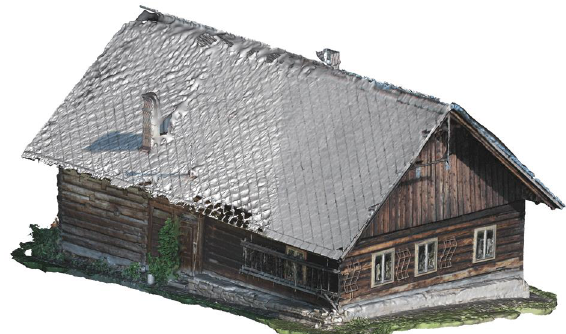
Figure 6. Example of the final DSM of the examined building, Vigantice (Vsetín dist.)